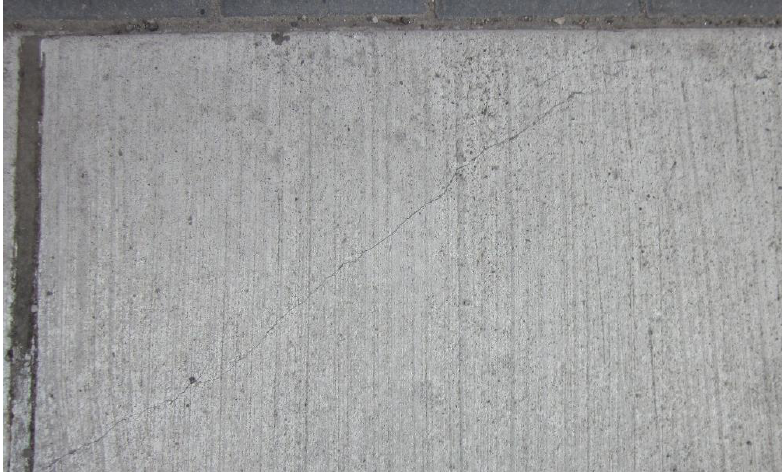
Figure 3. Early-age corner crack in a concrete side-walk slab; this crack appeared within 35 days after concrete placement; the concrete slab was cured by curing compound.